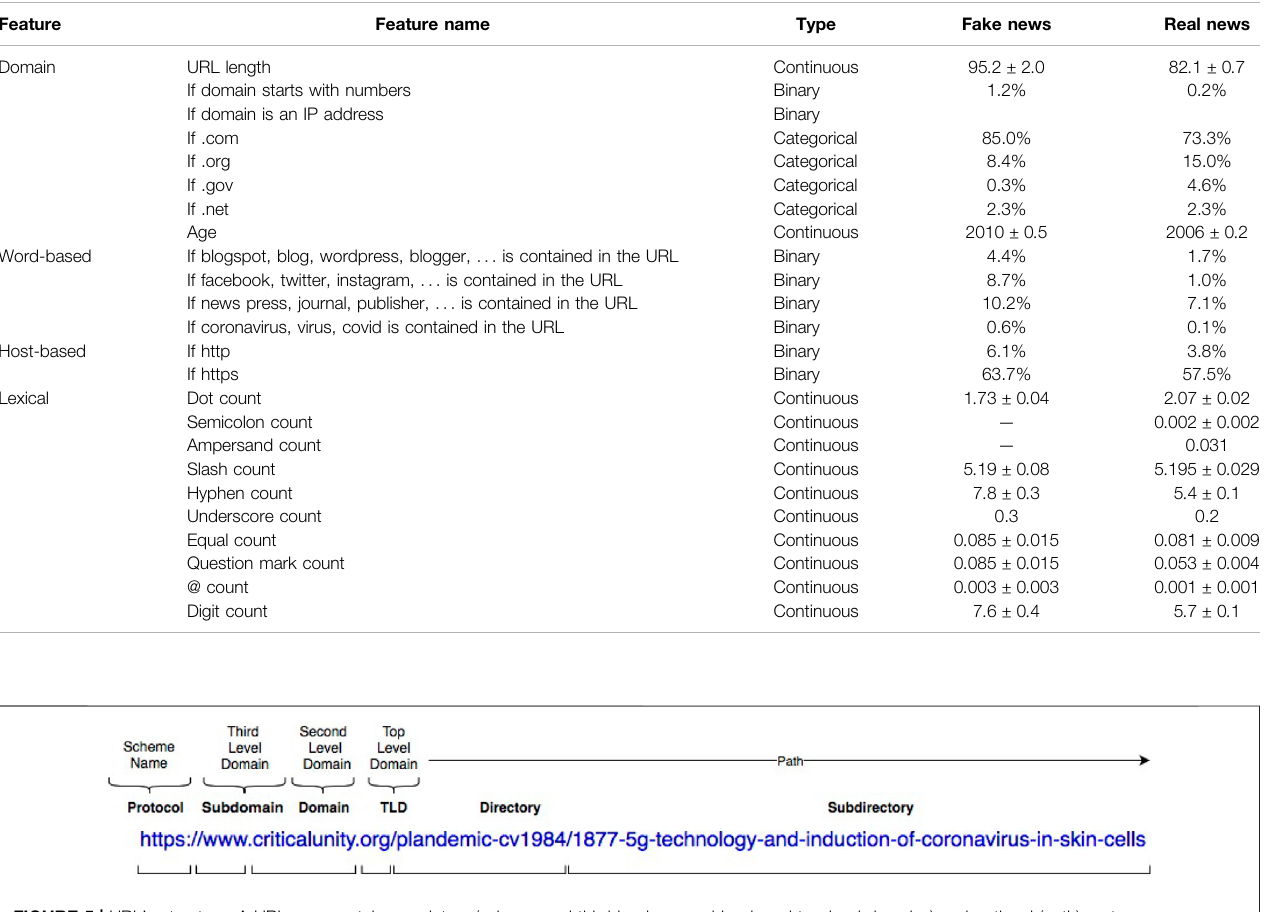
TABLE 2 | List of domain, host-based, and lexical features extracted from URLs. There are 8 domain features; 4 word-based features, which show the presence of speci fi c words in a URL; 2 host-based features; and 10 lexical features that include special characters ’ count or show the presence of digits in a URL. The purpose of feature engineering was to fi nd and explore new features to improve model performance for fake news detection. We used chi-square statistics and a correlation-based feature selection (CFS) approach. If reported, the error is the standard error of the mean.